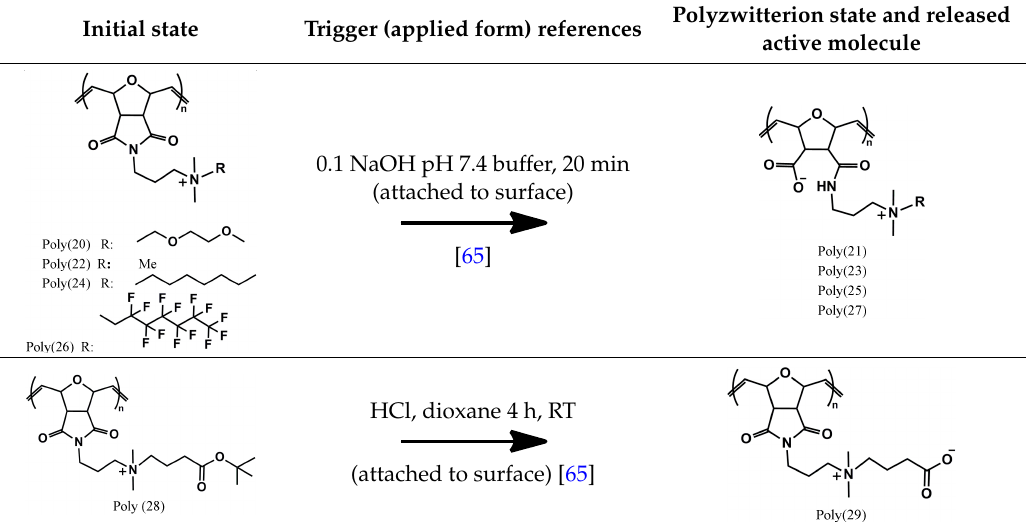
Table 1. Irreversible pH-triggered (meth)acrylic-based switches containing polyzwitterionic state.